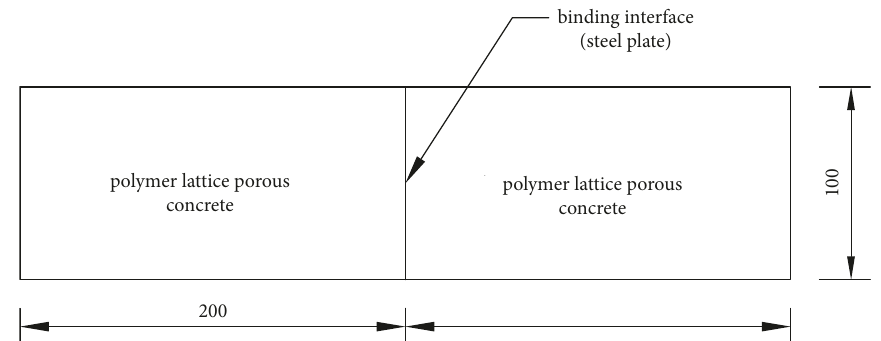
Figure 5: Formation of the polymer-modified cement lattice concrete and the steel plate interface for the interface flexural test (unit: mm).